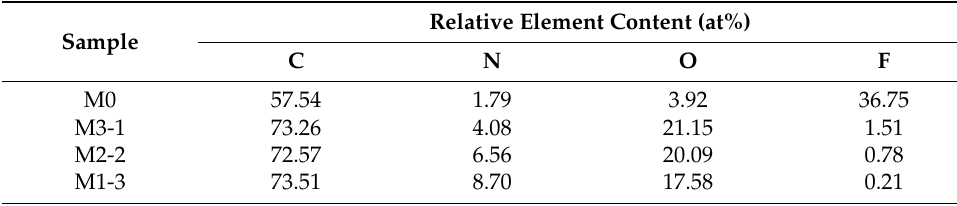
Table 1. Surface elemental composition of